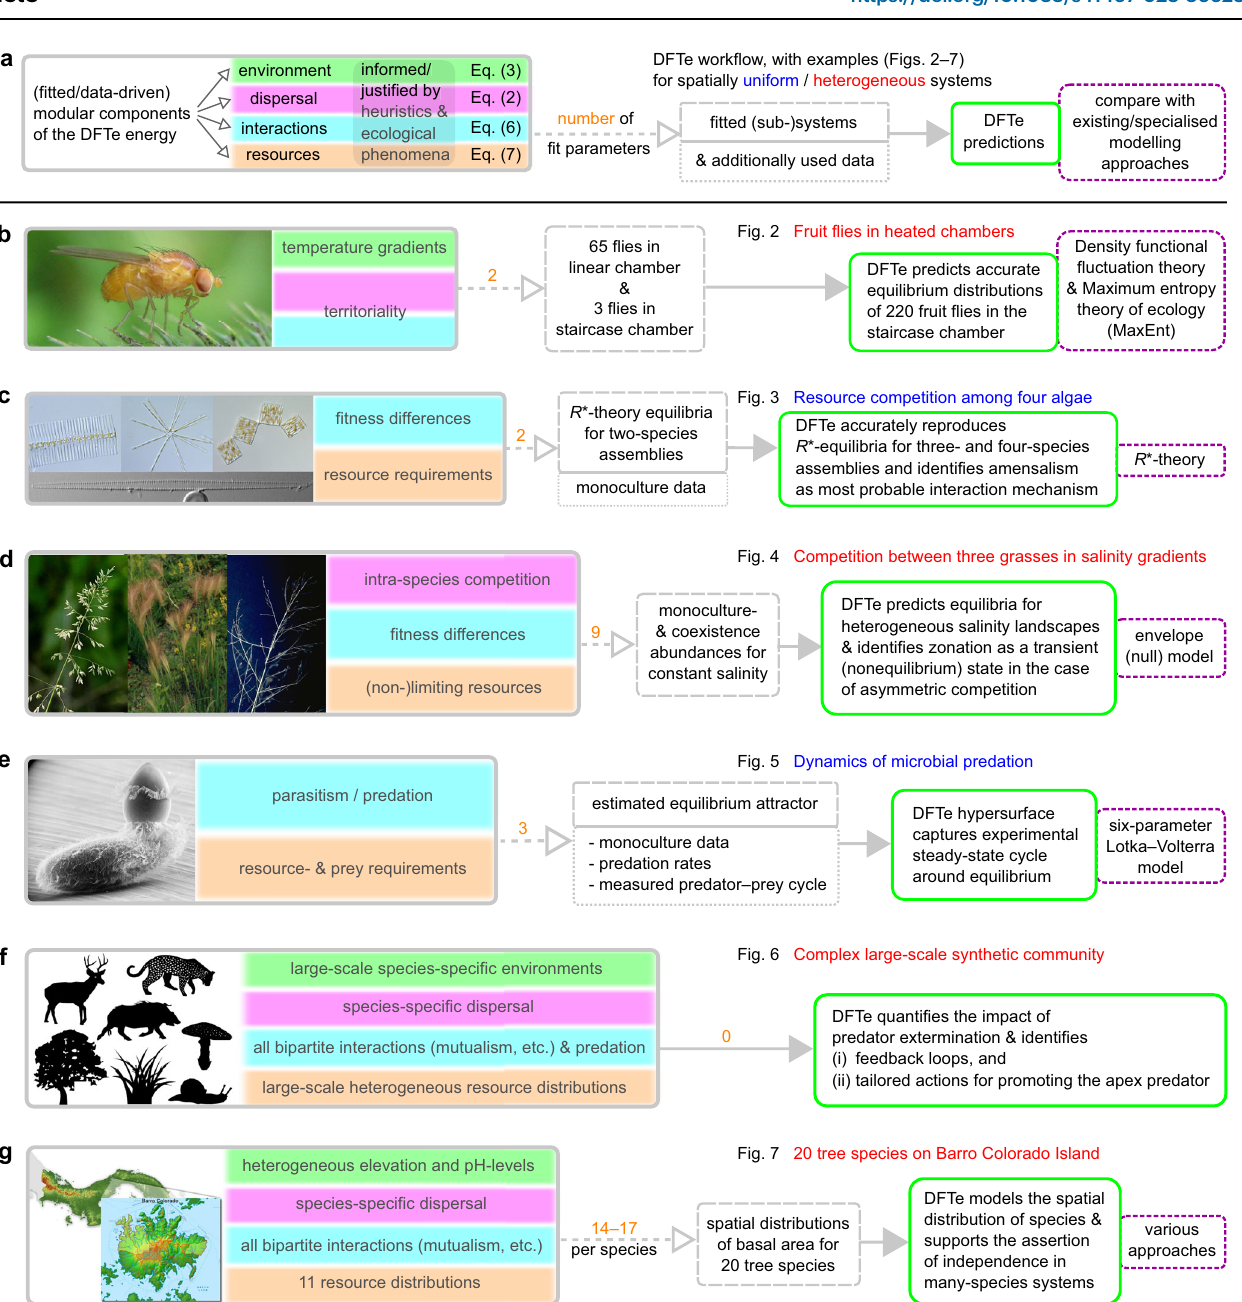
Fig. 1 | Framework for establishing, validating, and applying DFTe. a The work fl ow for extracting DFTe predictions from ecosystems whose properties